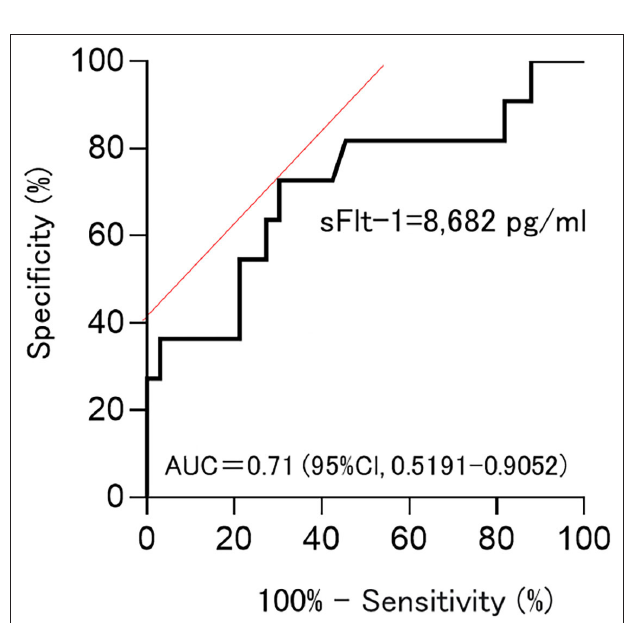
FIGURE 4 | Cutoff values for delivery in < 1 week; 7,394.5 pg/ml (AUC 0.78; 0.78, 95%Cl,